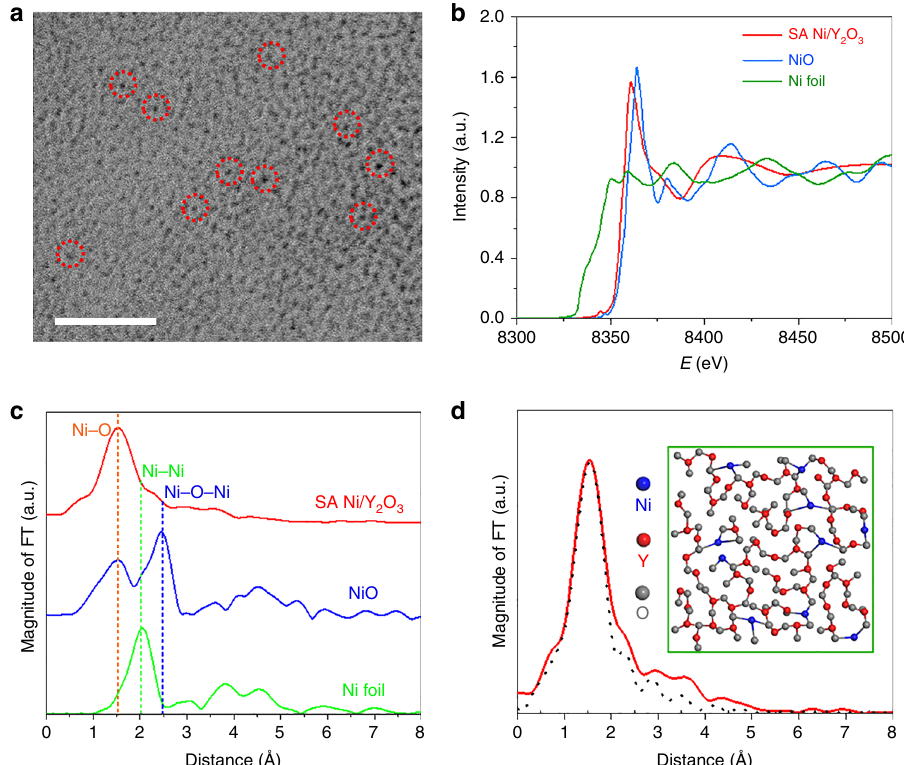
Fig. 3 Characterization of the Ni in the SA Ni/Y 2 O 3 nanosheets. a Aberration-corrected TEM image of the SA Ni/Y 2 O 3 nanosheets. b EXAFS spectra of the Ni K-edge of the SA Ni/Y 2 O 3 nanosheets, NiO and Ni foil. c Fourier transform (FT) of the Ni K-edge of the SA Ni/Y 2 O 3 nanosheets, NiO and Ni foil. d Schematic model of the SA Ni/Y 2 O 3 nanosheets and the corresponding FT-EXAFS fi tting curves for the SA Ni/Y 2 O 3 nanosheets. The scale bar in a is 2